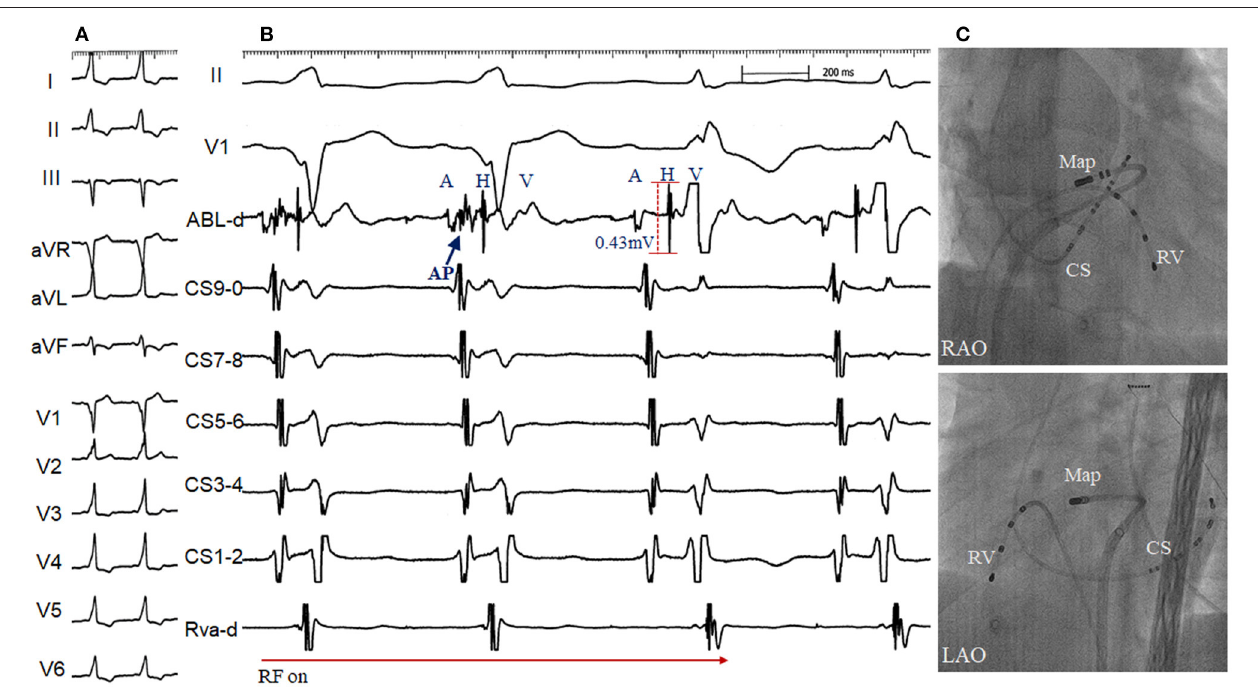
FIGURE 6 | Radiofrequency (RF) delivery (A) and fluoroscopic image (C) at the apex of the interventricular membranous septum via transseptal approach in a patient with supra-paraseptal ventricular preexcitation (B) and 2 failed RF attempts at the right para-Hisian region and non-coronary cusp (Right bundle branch block developed after the second ablation). The accessory pathway blocked within 2s during the first RF application, starting with 15W and up-titrated to 30W. Note a distinct accessory pathway (AP) and large His activation (amplitude 0.43mV) was recorded at the successful site. ABL, ablation catheter; RV, right ventricle. Abbreviations as in Figure 1